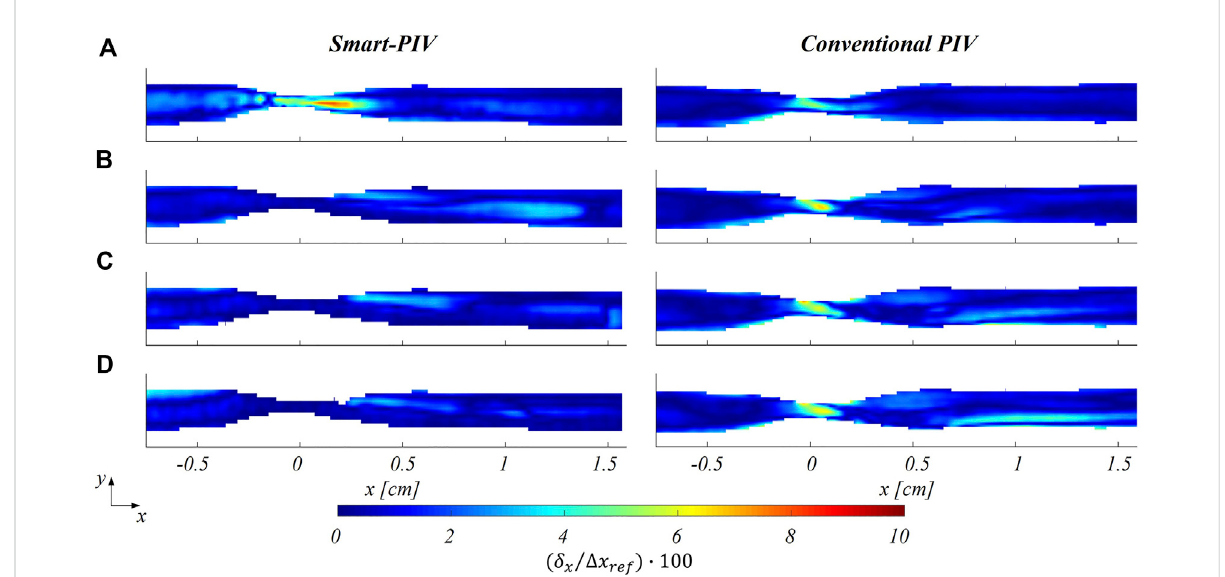
FIGURE 11 Color maps of smart (left panel) and conventional (right panel) PIV displacement error along the streamwise direction δ x , normalized to the maximum streamwise particle displacement ( Δ x r ef ) at four different fl ow regimes: (A) Re inflow = 21; (B) Re inflow = 64; (C) Re inflow = 107; (D) Re inflow = 171 for the stenosed LAD phantom.